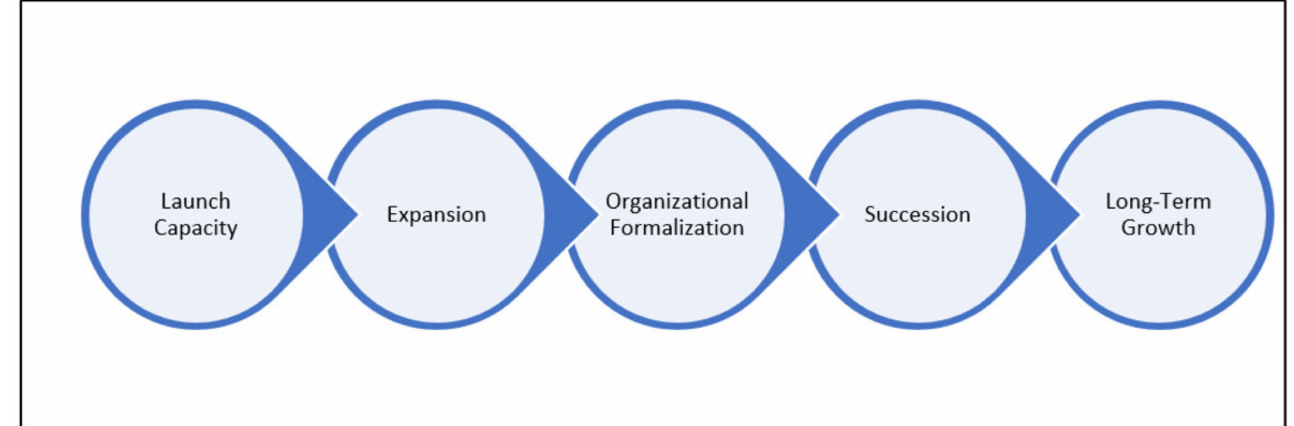
Figure 1. Crossing Chasms Stages of Growth adapted from Chaston